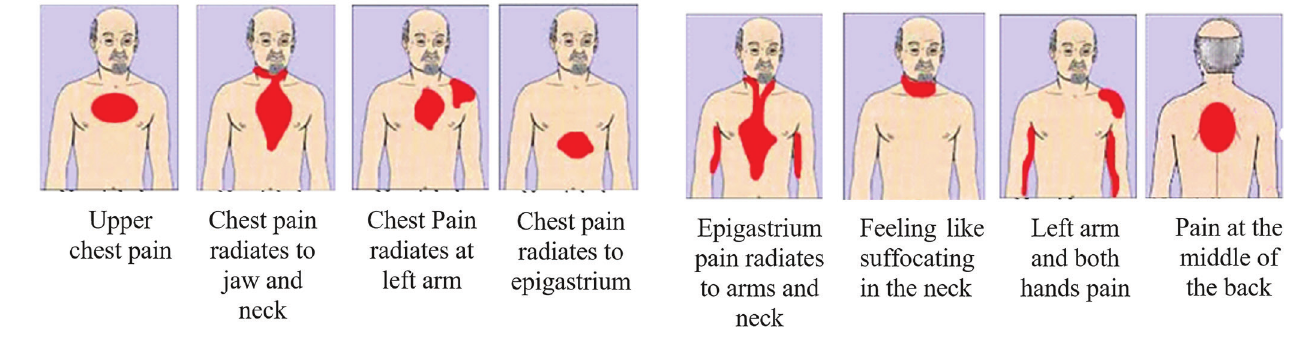
Figure 1 - Indicators and symptoms of chest pain at the heart